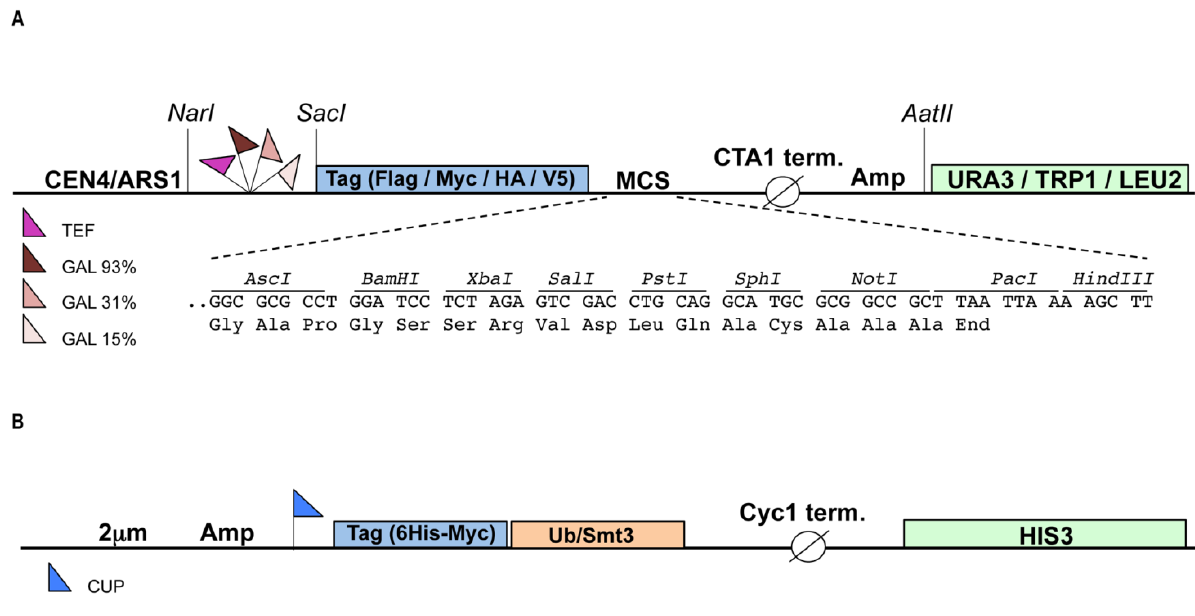
FIGURE 1: Schematic representation of the constructed vectors. The pRA vectors (A) are yeast centromeric shuttle plasmids that carry an auxotrophic marker ( URA3 , TRP1 or LEU2 gene) for selection in yeast and the ampicillin (Amp) resistance gene for selection in E. coli. The gene of interest can be cloned into the multiple cloning site (MCS) under control of either the inducible GAL1 promoter (3 different strengths) or the constitutive TEF promoter. The expressed protein will bear any of the four (Flag, Myc, HA or V5) N-terminal epitope tags allowing easy detection. All restriction sites indicated are unique. (B) High copy (2 μm) yeast shuttle plasmids carrying the HIS3 auxotrophic marker and expressing either 6xHis-Myc tagged ubiquitin (Ub) or SUMO (Smt3) under control of the copper inducible promoter (CUP). CTA1 and Cyc1 term (inator), transcription termination sequences derived from the yeast Catalase A and Cytochrome c1 gene,